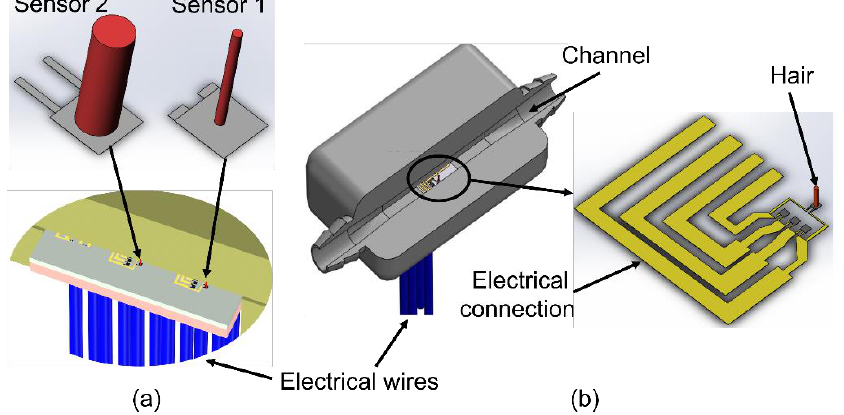
Figure 3. Schematics of the volumetric flow sensor. ( a ) Two AHCs on one silicon die; ( b ) cutaway view of the sensor assembly and a close-up of an individual AHC.